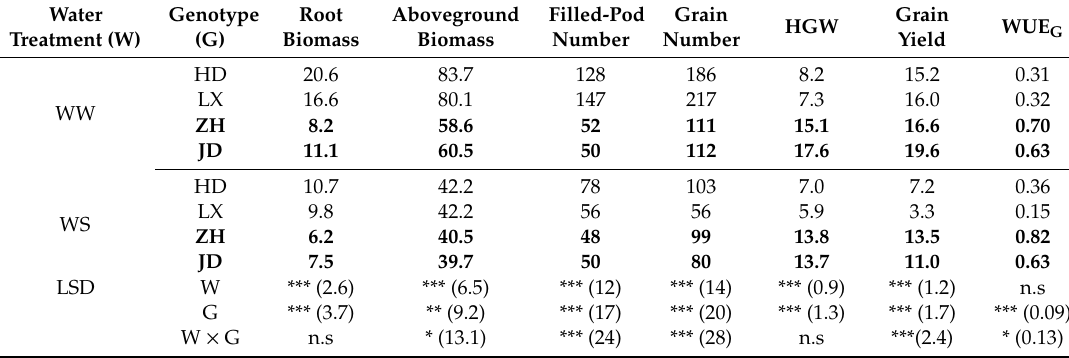
Figure 4. The relationship between the di ff erence of yield and the di ff erence in water uptake between the irrigated (IR: 40 mm water applied at flowering) and rainfed (RF: no water applied at flowering) in the field experiments in 2011 and 2012. The parameters of the fitted linear regression and its significance are shown: *** p < 0.001. Table 3. The root biomass (g plant − 1 ), aboveground biomass (g plant − 1 ), filled-pod number (plant − 1 ), grain number (plant − 1 ), hundred-grain weight (HGW, g), grain yield (g plant − 1 ), and water use e ffi ciency for grain yield (WUE G , g L − 1 ) for the four soybean genotypes (two landraces: Huangsedadou (HD) and Longxixiaohuangpi (LX) and two recent cultivars: Zhonghuang 30 (ZH) and Jindou 19 (JD) ( bold )) under well-watered (WW) and cyclical water stress (WS) in a pot experiment in 2014. The LSD values are given in parenthesis with level of significance: n.s not significant, * p < 0.05, ** p < 0.01, *** p <